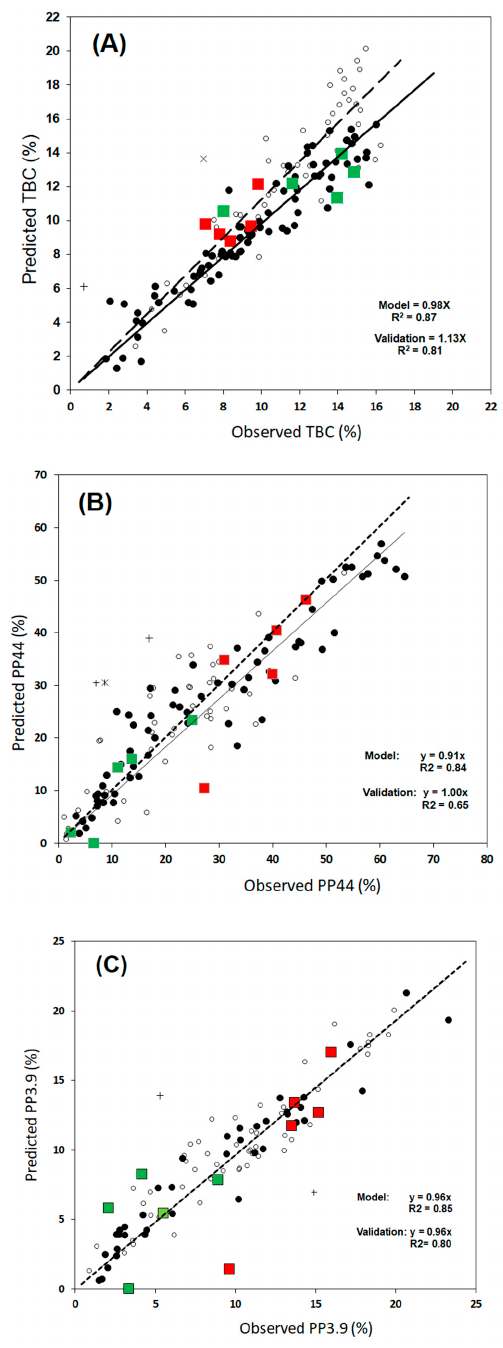
Figure 9. Comparison of spectrally derived and experimentally measured variables for ( A ) total bitumen content, ( B ) % particle passing at 44 µ m, and ( C ) % particle passing at 3.9 µ m. Filled and open circles represent the modeling and validation suite, respectively. + (modeling) and x (validation) mark the position of outliers (root mean square (RMS) error beyond 5% or 95% population). Solid and dashed line are best fits for the modeling and validation data, respectively. The ten samples used for the flotation experiment are shown as red and green squares for brown and dark froths,